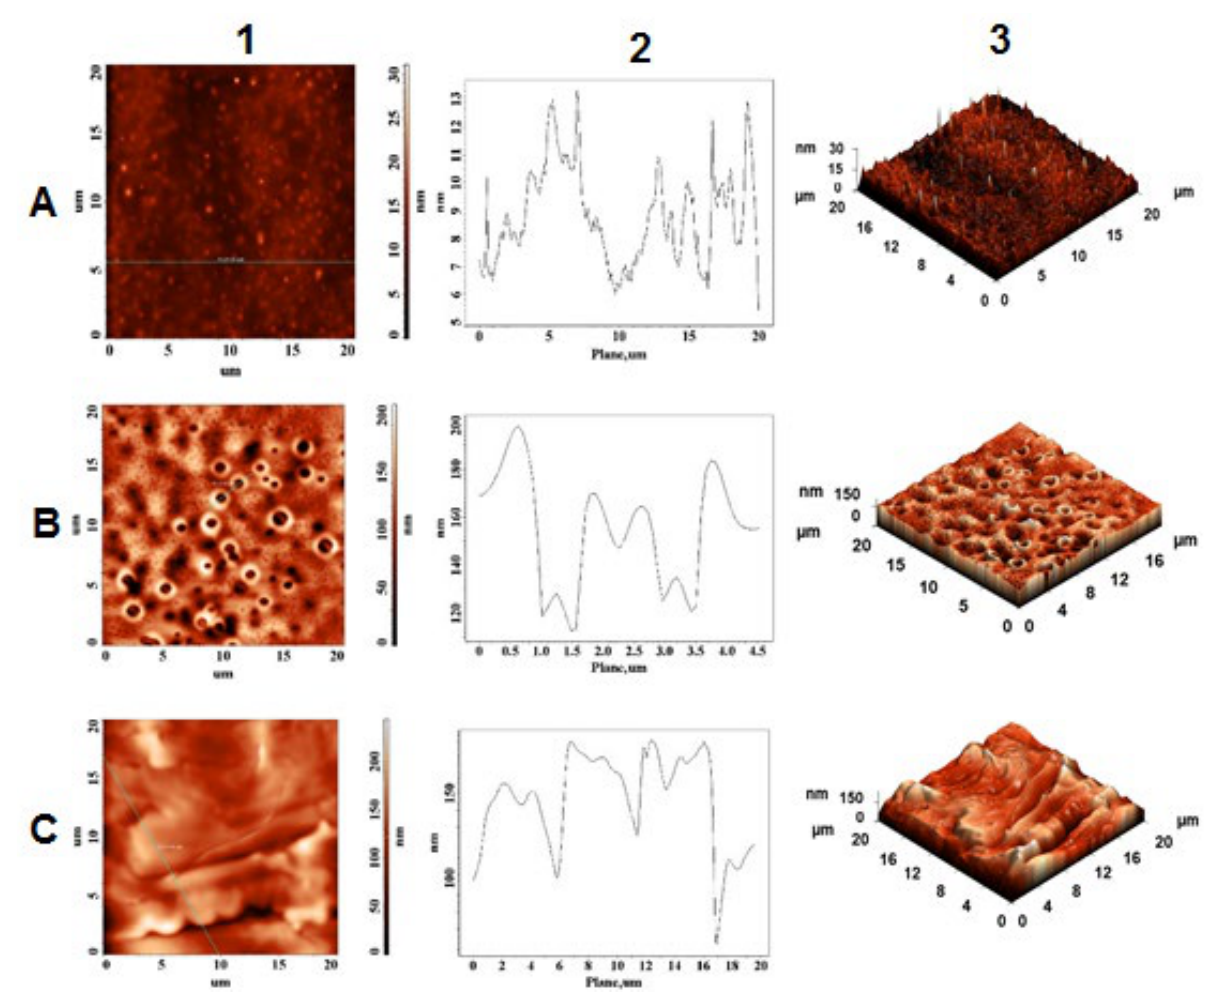
Figure 11. AFM images of NAP and A β (9–16) peptide mixture ( A ) in the presence of copper ions ( B ) and zinc ions ( C ); (1) height of AFM images; (2) plot height distribution of particles along the profile line; and (3) 3D AFM